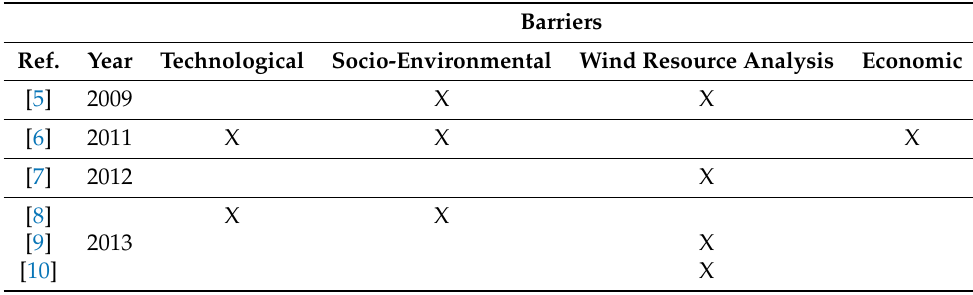
Table 1. Barriers for urban wind energy implementation. State of the art.